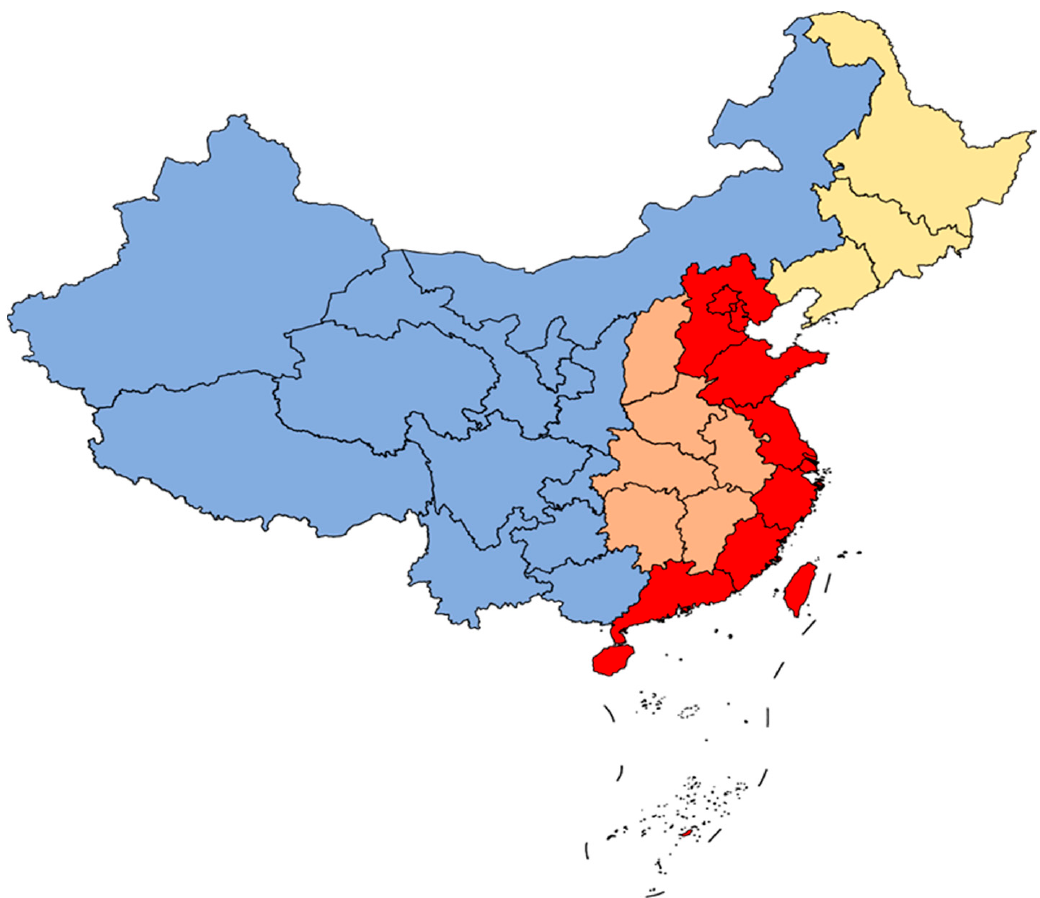
Figure 2. Regional division of East (Marked in red), Central (Marked in light brown), West (Marked in light blue) and Northeast (Marked in light yellow) in China. According to the division standard on National Bureau of Statistics of China, China is divided into four regions: the East, the Central, the West and the northeast. The eastern region includes Beijing, Tianjin, Hebei, Shanghai, Jiangsu, Zhejiang, Fujian, Shandong, Guangdong, Hainan and Taiwan; The Central region includes Shanxi, Anhui, Jiangxi, Henan, Hubei and Hunan; The western region includes inner Mongolia, Guangxi, Chongqing, Sichuan, Guizhou, Yunnan, Shaanxi, Gansu, Ningxia, Qinghai, Xinjiang and Tibet. Northeast China includes Liaoning, Jilin and Heilongjiang. Due to the lack of data, Tibet and Taiwan Province were not included in the analysis.